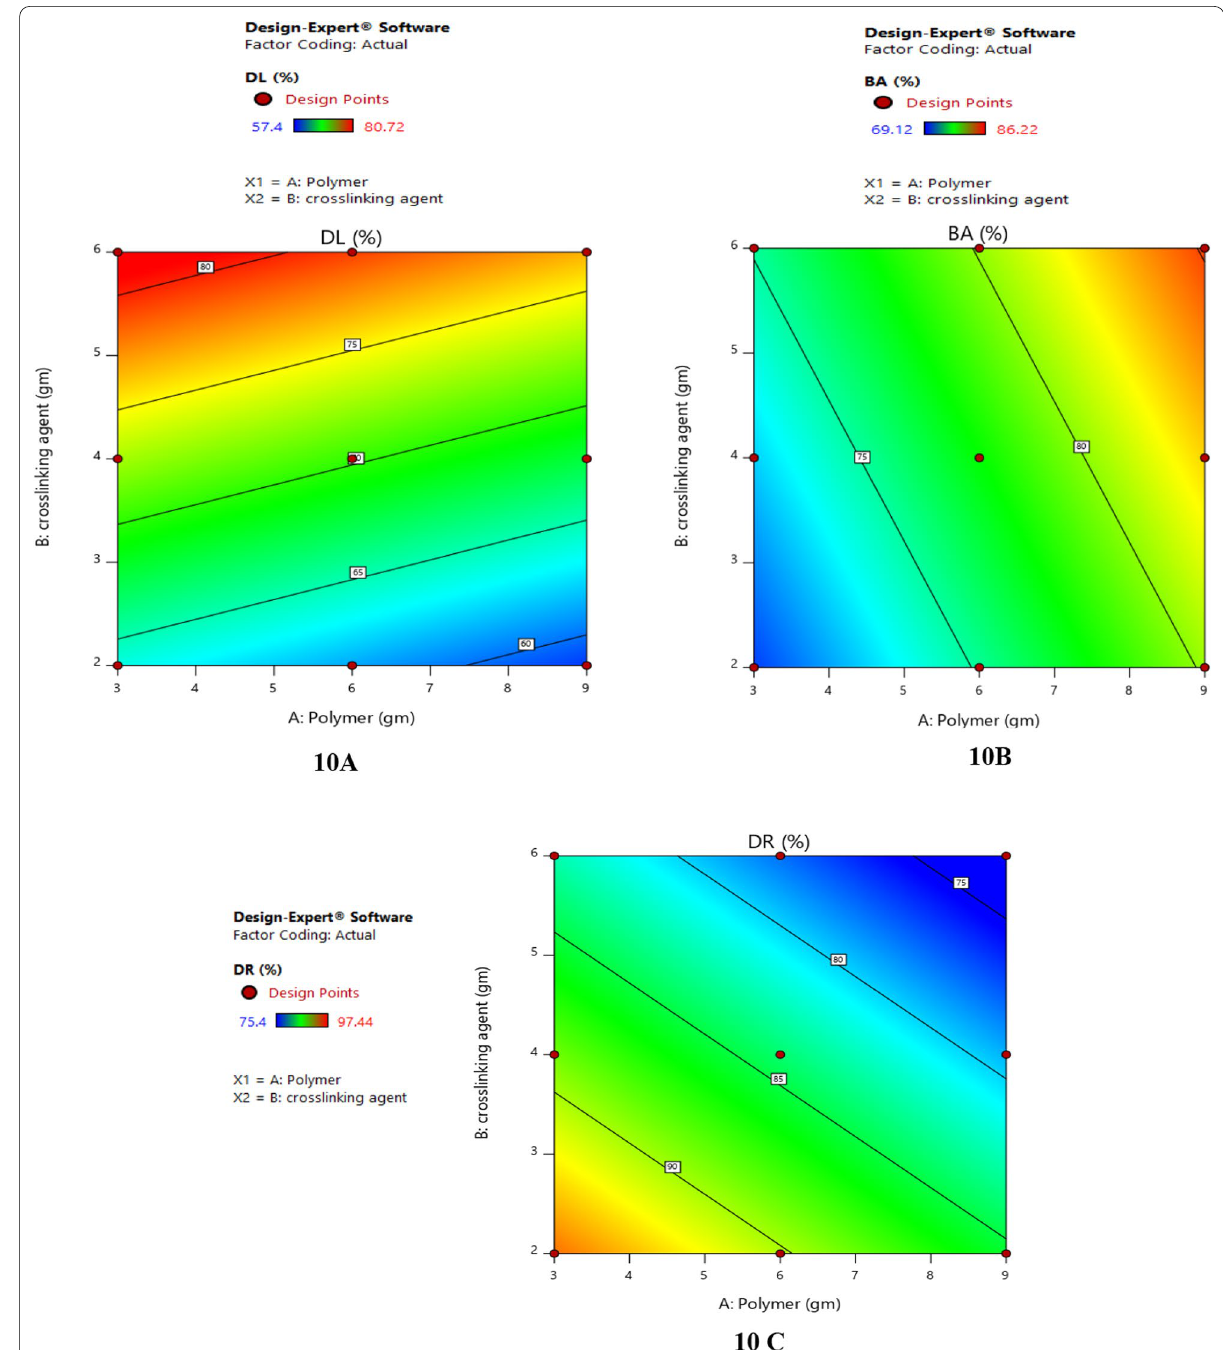
Fig. 10 The contour plots generated by the software to evaluate the relationship between polymer concentration and amount of cross-linker and their effect on different parameters A contour plot for % drug loading B contour plot for % bio adhesion c contour plot for % drug